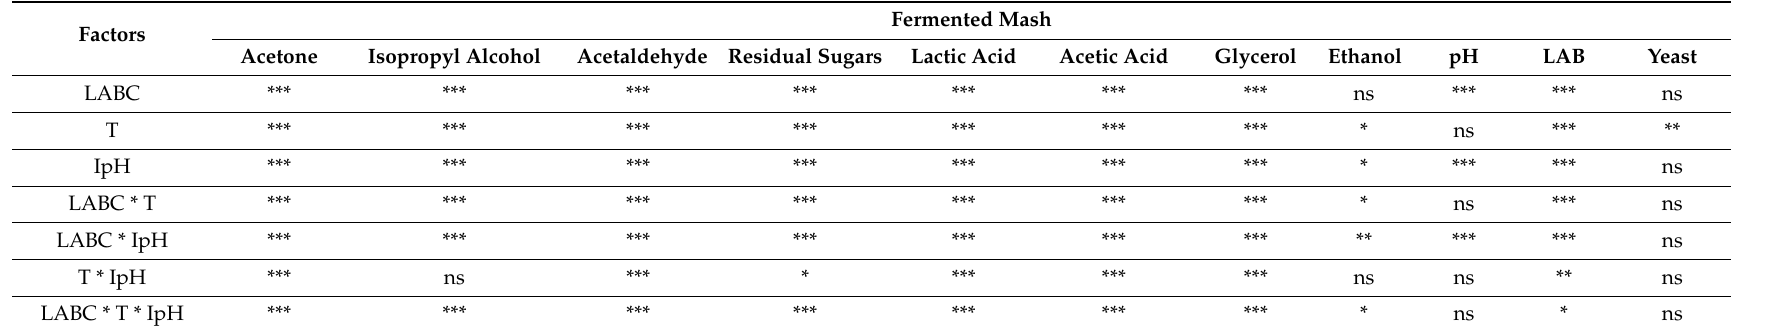
Table 3. Results of three-way